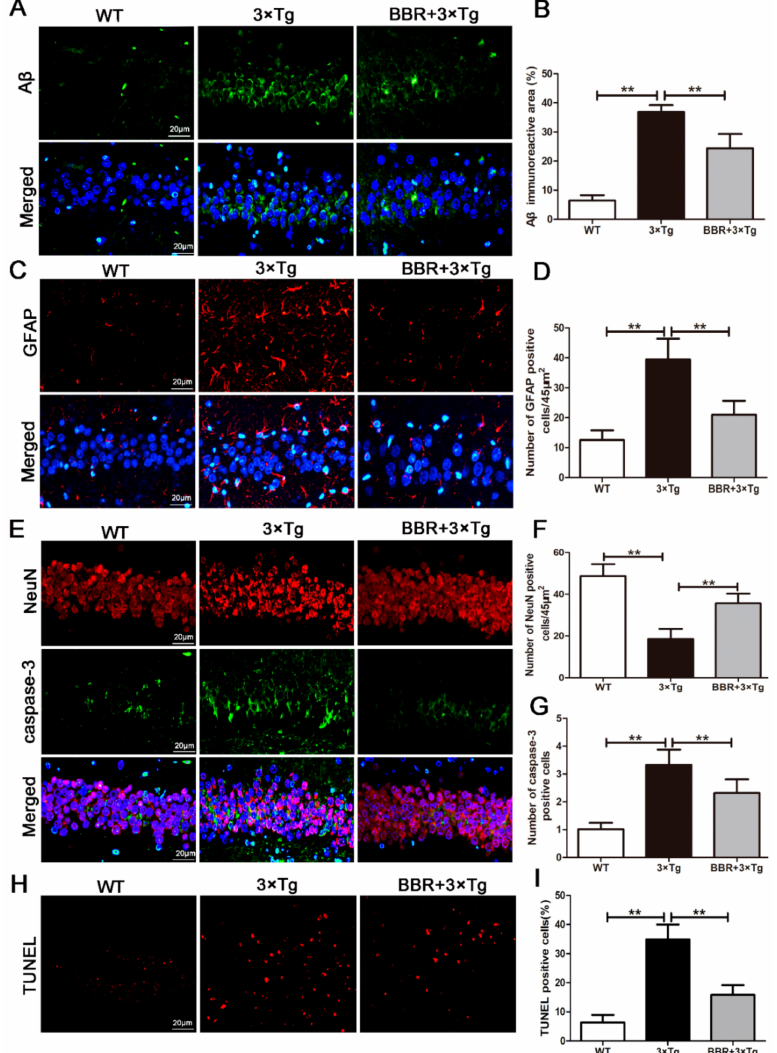
Figure 3. BBR reduced the production of A β and inhibited apoptosis in the brains of 3 × Tg AD mice. ( A ) Immunofluorescence of A β (green) in the hippocampi of mice from the three groups. Scale bar: 20 µ m. ( B ) Quantification of A β immunoreactivity in the hippocampi of mice. ( C ) Im- munofluorescence of GFAP (red) in the hippocampi of mice from the three groups. Scale bar: 20 µ m. ( D ) Quantification of GFAP immunoreactivity in the hippocampi of mice. ( E ) Immunofluorescence of NeuN (red) and Caspase-3 (green) in the hippocampi of mice from the three groups. Scale bar: 20 µ m. ( F ) Quantification of NeuN and Caspase-3 immunoreactivity in the hippocampi of mice. ( G ) Quantification of Caspase-3 immunoreactivity in the hippocampi of mice. ( I ) The number of TUNEL-positive neurons in each group was averaged. ( H ) The number of TUNEL-positive neurons (red). Scale bar: 20 µ m. WT, wild-type mice; 3 × Tg, 3 × Tg AD mice; BBR + 3 × Tg; 3 × Tg AD mice were given BBR at 100 mg/kg/day. One-way ANOVA and Dunnett’s post-hoc test were used to analyze all the data, which are presented as mean ± SD; n = 12 animals/group. ** p <